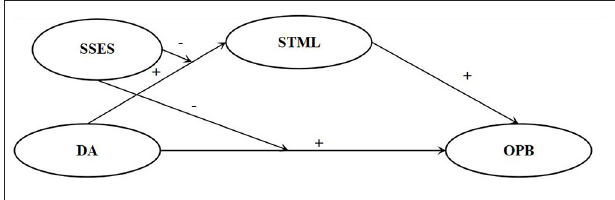
FIGURE 1 | The hypothesized model. SSES, subjective socioeconomic status; DA, dispositional awe; STML, self-transcendent meaning in life; OPB, online prosocial